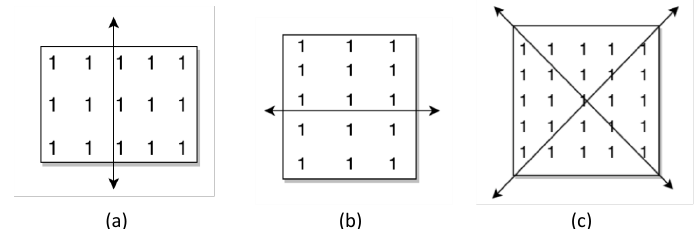
Figure 6. Filter coefficients for collecting HOS features: ( a ) 0 ◦ in horizontal direction, ( b ) 90 ◦ in vertical direction, ( c ) − 45 ◦ and 45 ◦ in diagonal